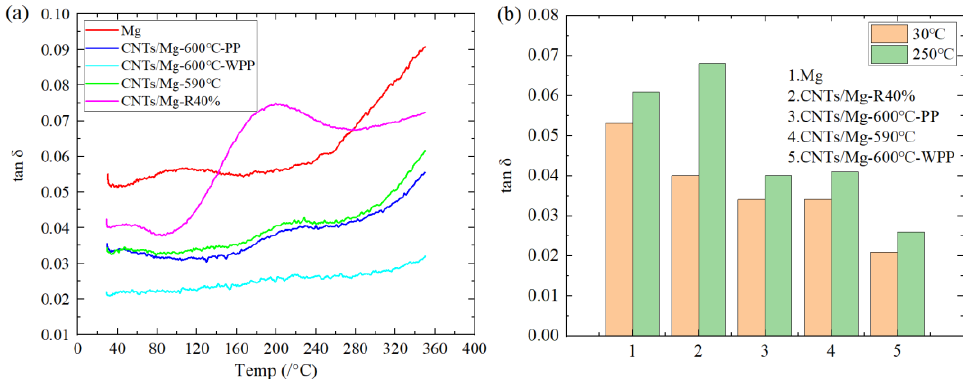
Figure 10. Effects of different preparation processes on damping properties: ( a ) temperature-dependent damping curves (tan δ ~T) and ( b ) room temperature (25 ◦ C) and high temperature (250 ◦ C) damping capacity at ƒ = 1 Hz.